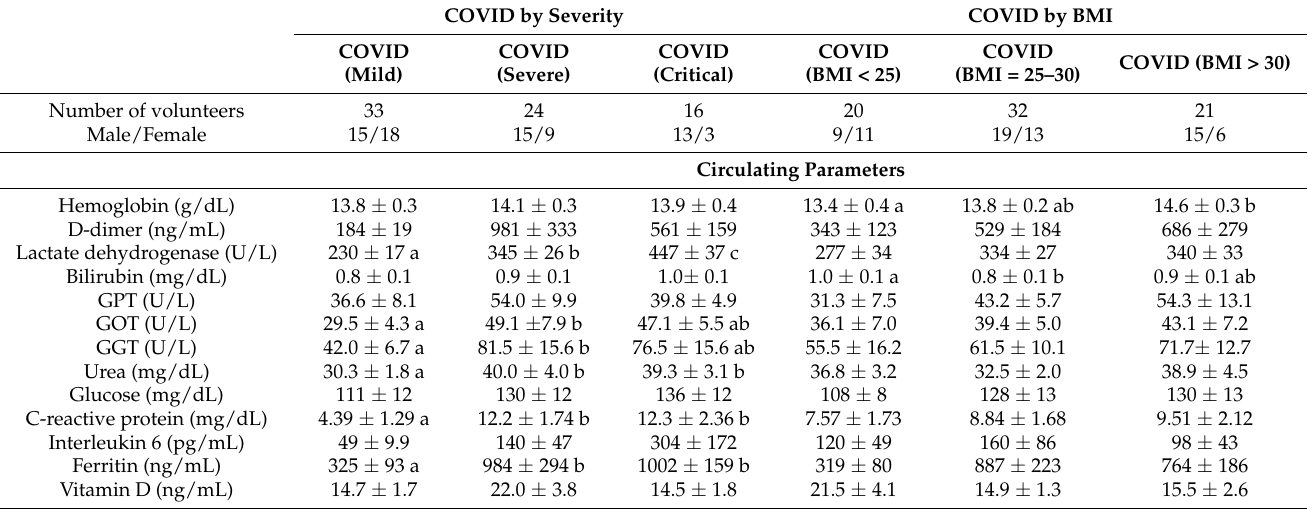
Table 2. Circulating parameters in COVID-19 patients. Data in each group are analyzed considering all the individuals (women and men together), and stratified by COVID-19 severity (mild, severe, or critical) or by body mass index (BMI) range. Data are mean ± SEM. Statistics: differences between stratified groups were analyzed by one-way ANOVA followed by least significant difference (LSD) post-hoc test, a (cid:54) = b (cid:54) = c ( p < 0.05). COVID by Severity COVID by